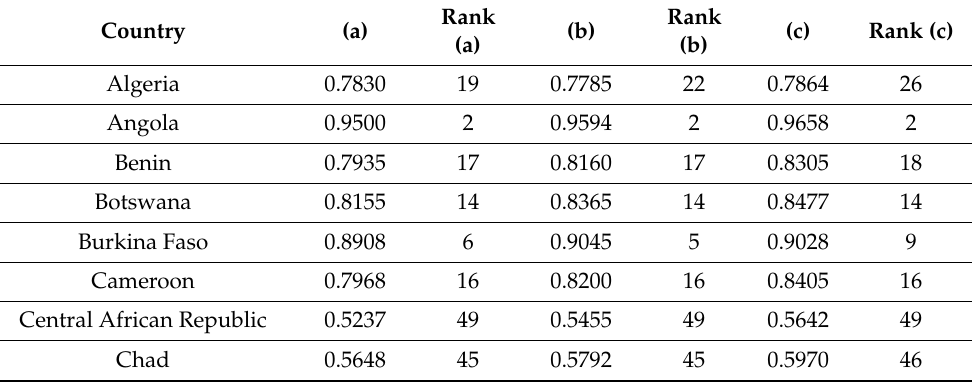
Table 12. Cumulative results for the index of r ref − i access to electricity—GDP pc. Source: own